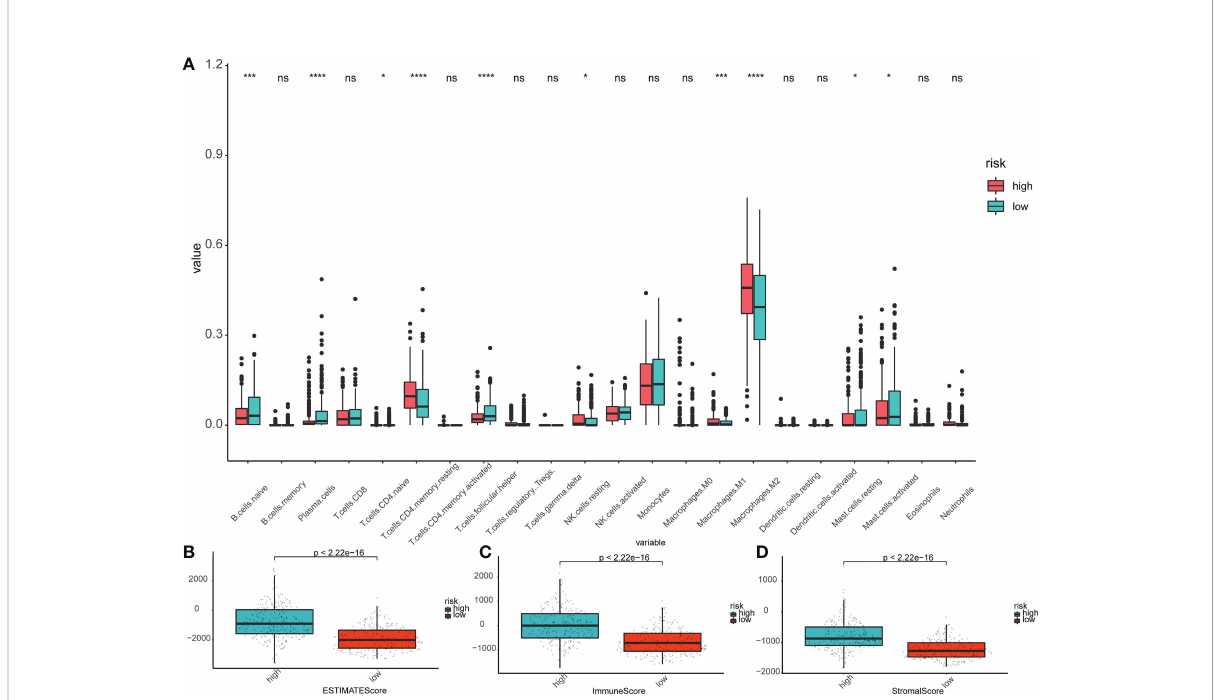
FIGURE 6 Immunoassay in the risk subgroups. (A) Boxplot showing the differential abundance of 22 in fi ltrating immune cells calculated by CIBERSORT between the high- and low-risk groups in LGG. ∗ P< 0.05; ∗∗∗ P< 0.001; ∗∗∗∗ P< 0.0001; ns: not signi fi cant. (B-D) The higher expression level of Estimate Scores (B) , Immune Score (C) , and Stroma Score (D) correlated with the high-risk group. The green box shows the low-risk group, and the red box shows the high-risk